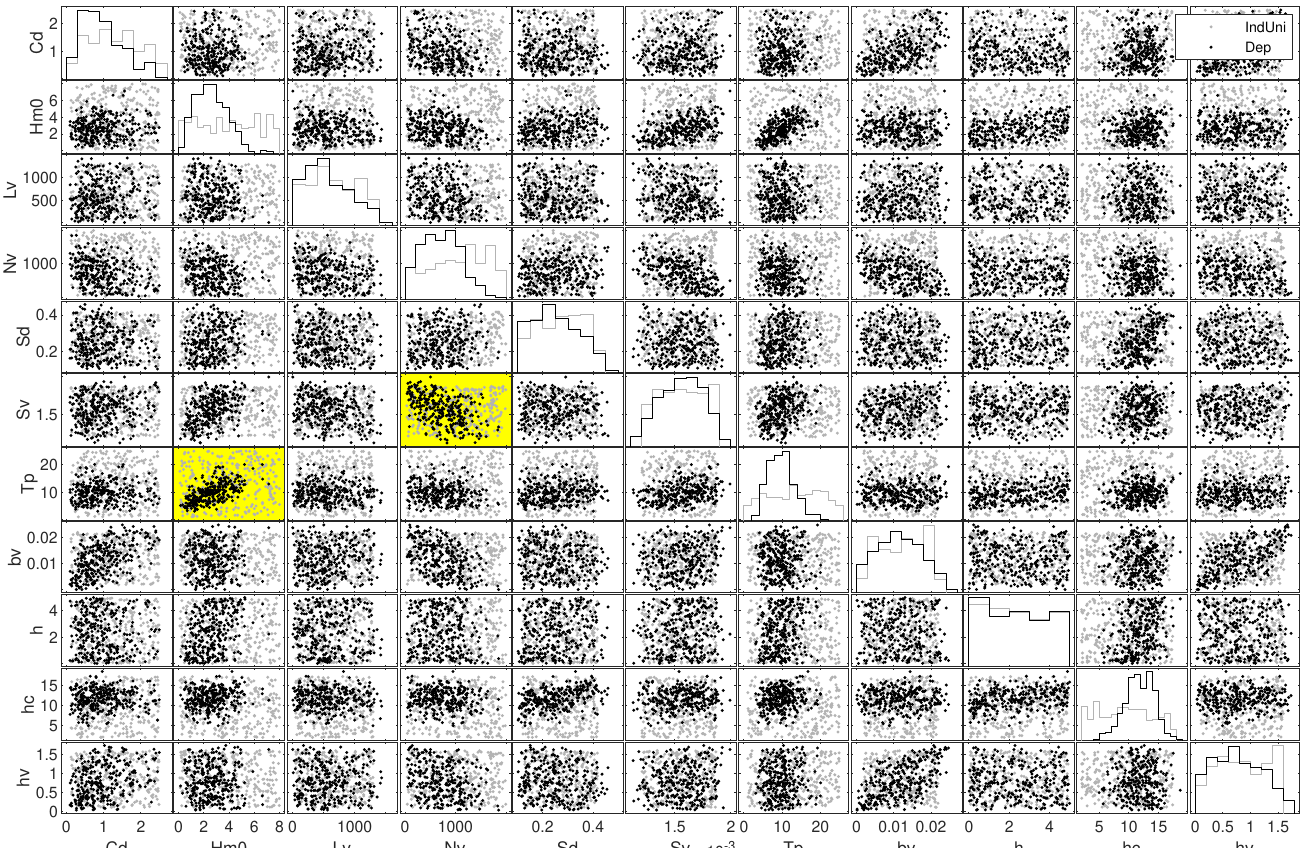
Figure 12. Comparison of varied vegetated hydrodynamic conditions sampled from an independent DAG with uniformly distributed variables (gray dots) and the stochastic model of this study (black dots) that was quantified with distributions (Table 2) and correlations (Table 4). Yellow panels shows the distinct sampling of the variable pair with positive H m 0 − T p and negative dependence N v − S v